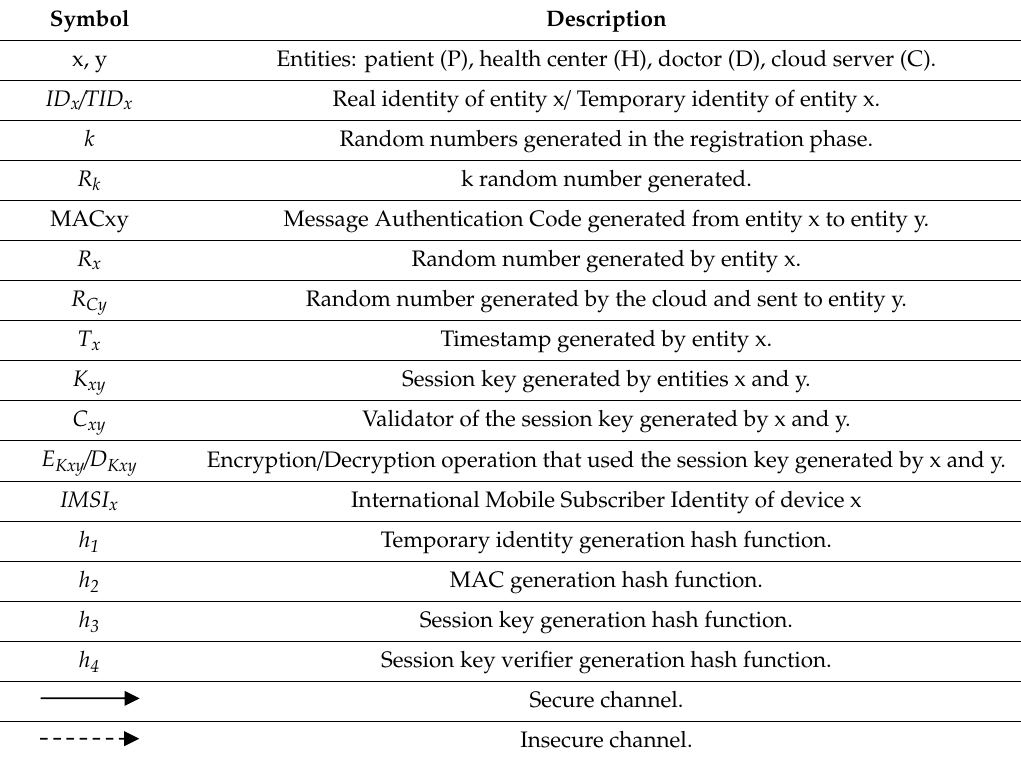
Table 2. Notations used in the protocol.